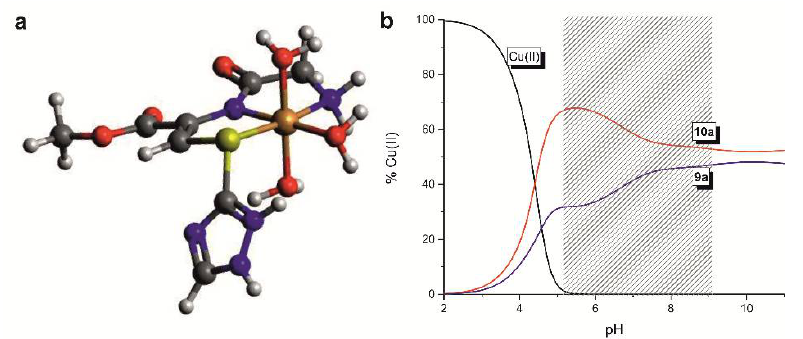
Figure 3. ( a ) The proposed structure of the CuL species formed by the 9a , ( b ) the competition dia- gram for the 9a :Cu(II): 10a system with the nL1:nCu(II):nL2 = 1:1:1 molar